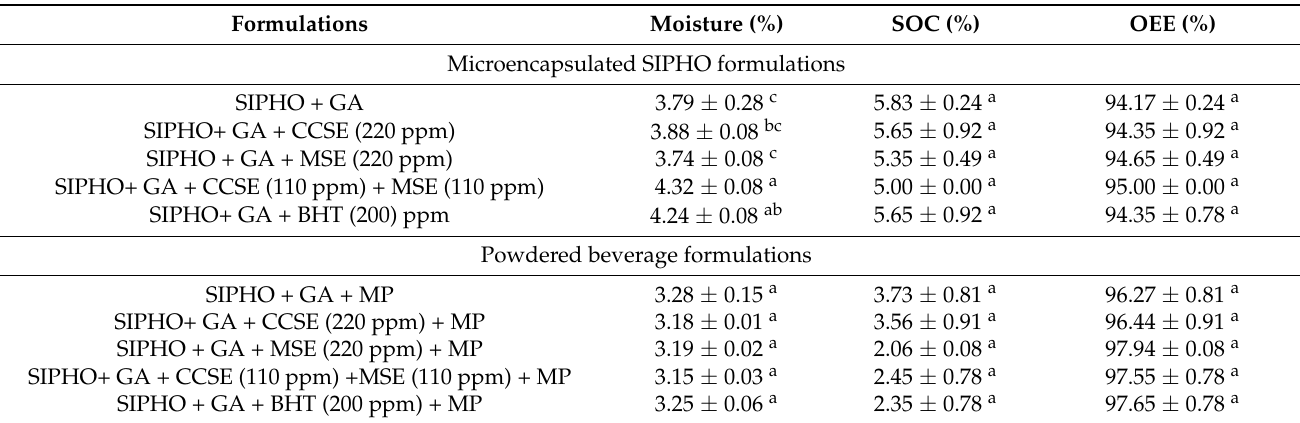
Table 2. Moisture (%), surface oil content (SOC) (%) and oil encapsulation efficiency (OEE) (%)